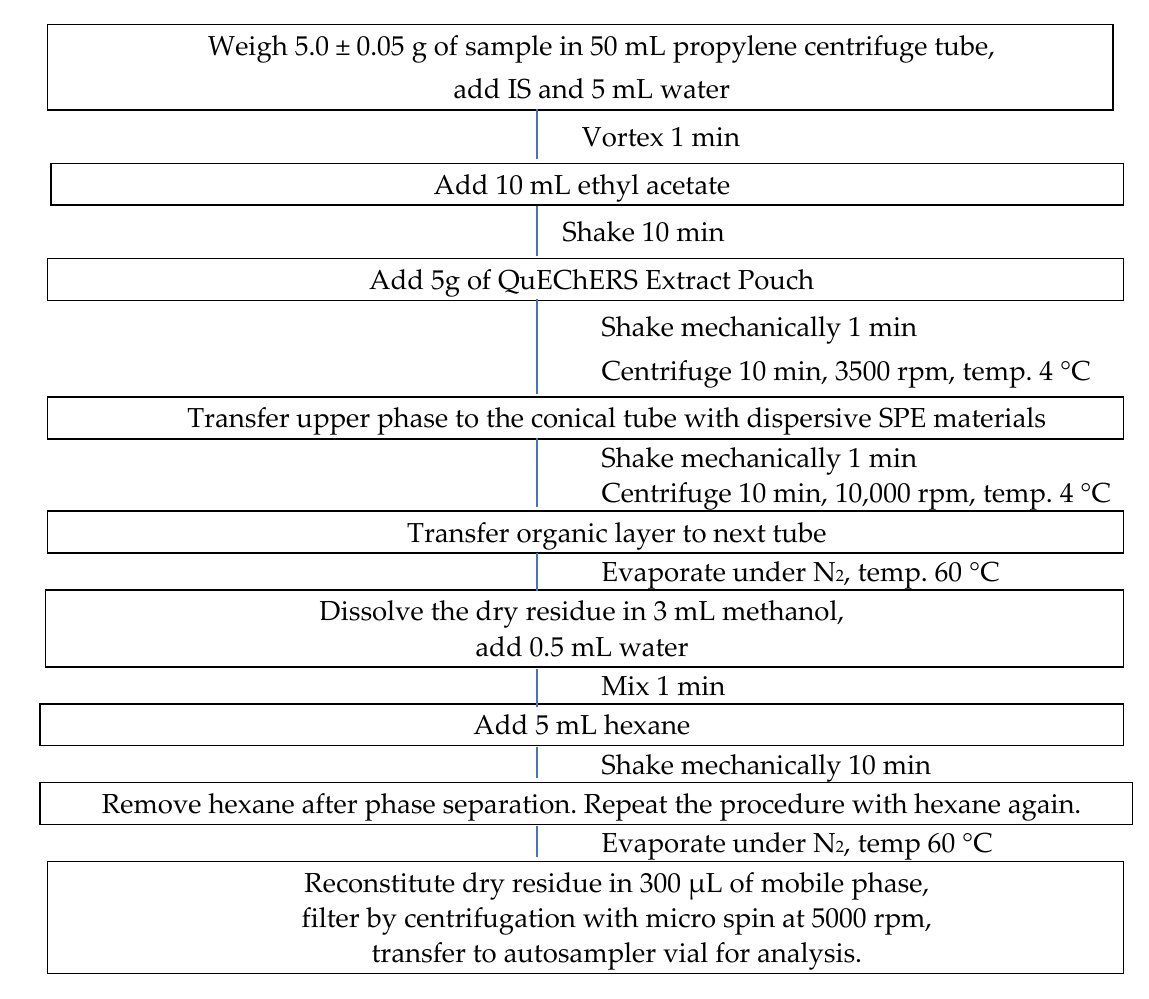
Figure 2. Diagram of the analytical procedure with the sample.